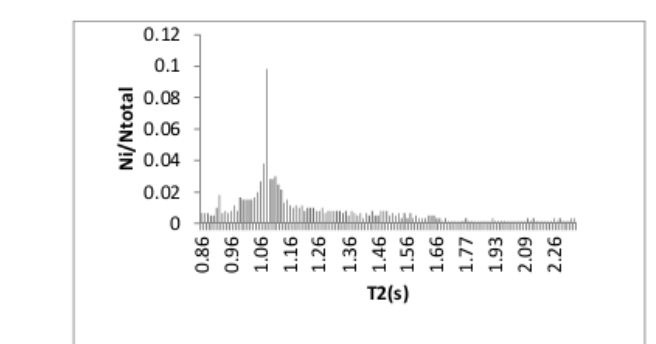
Fig. 2. Typical NMR spectra at different times.